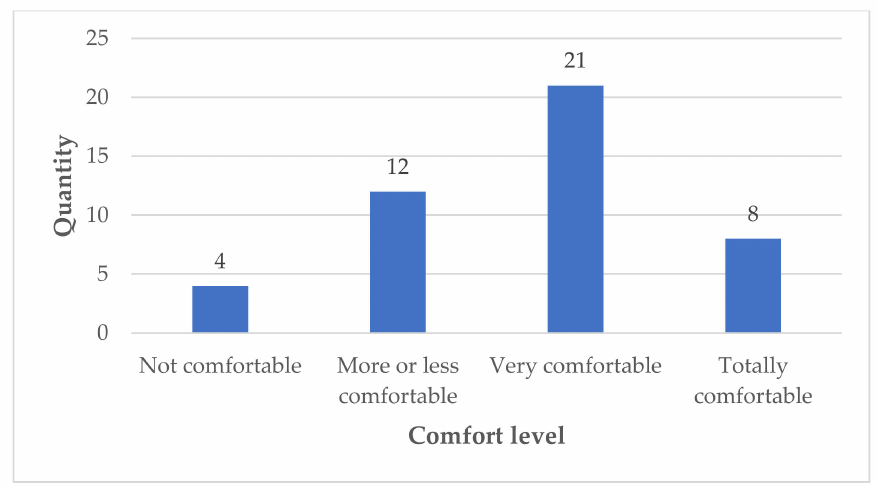
Figure 8. Orthosis